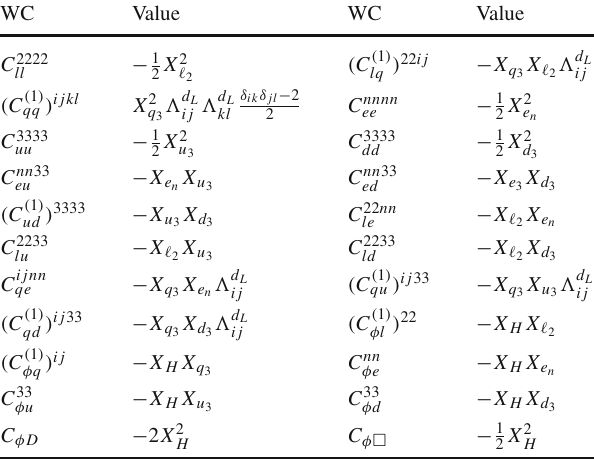
Table3 Non-zerodimension-6SMEFTWilsoncoefficientsintheWar- saw basis, obtained by integrating out the heavy X boson at scale M X . WC Value